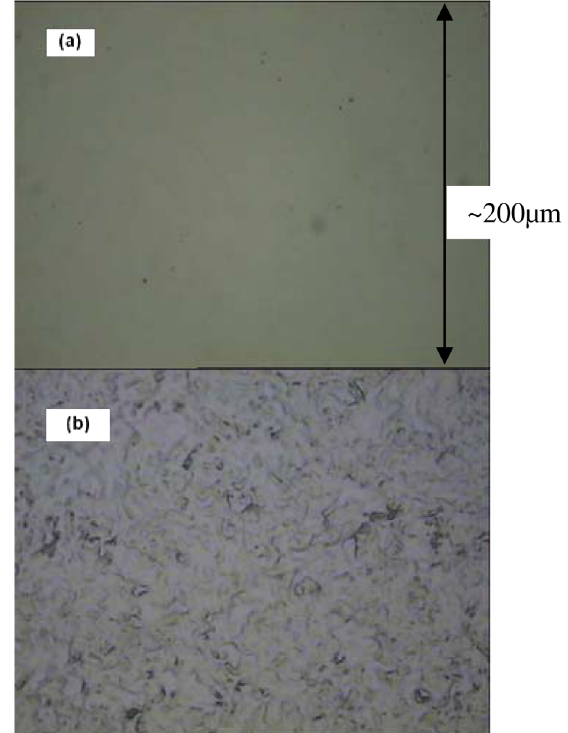
FIG. 7. (a) Smooth surface obtained after EP in fresh EP mixture (top) and (b) typical features observed on samples after EP in an aged mixture, with limited fluorine diffusion (bottom). The same scale is used for both